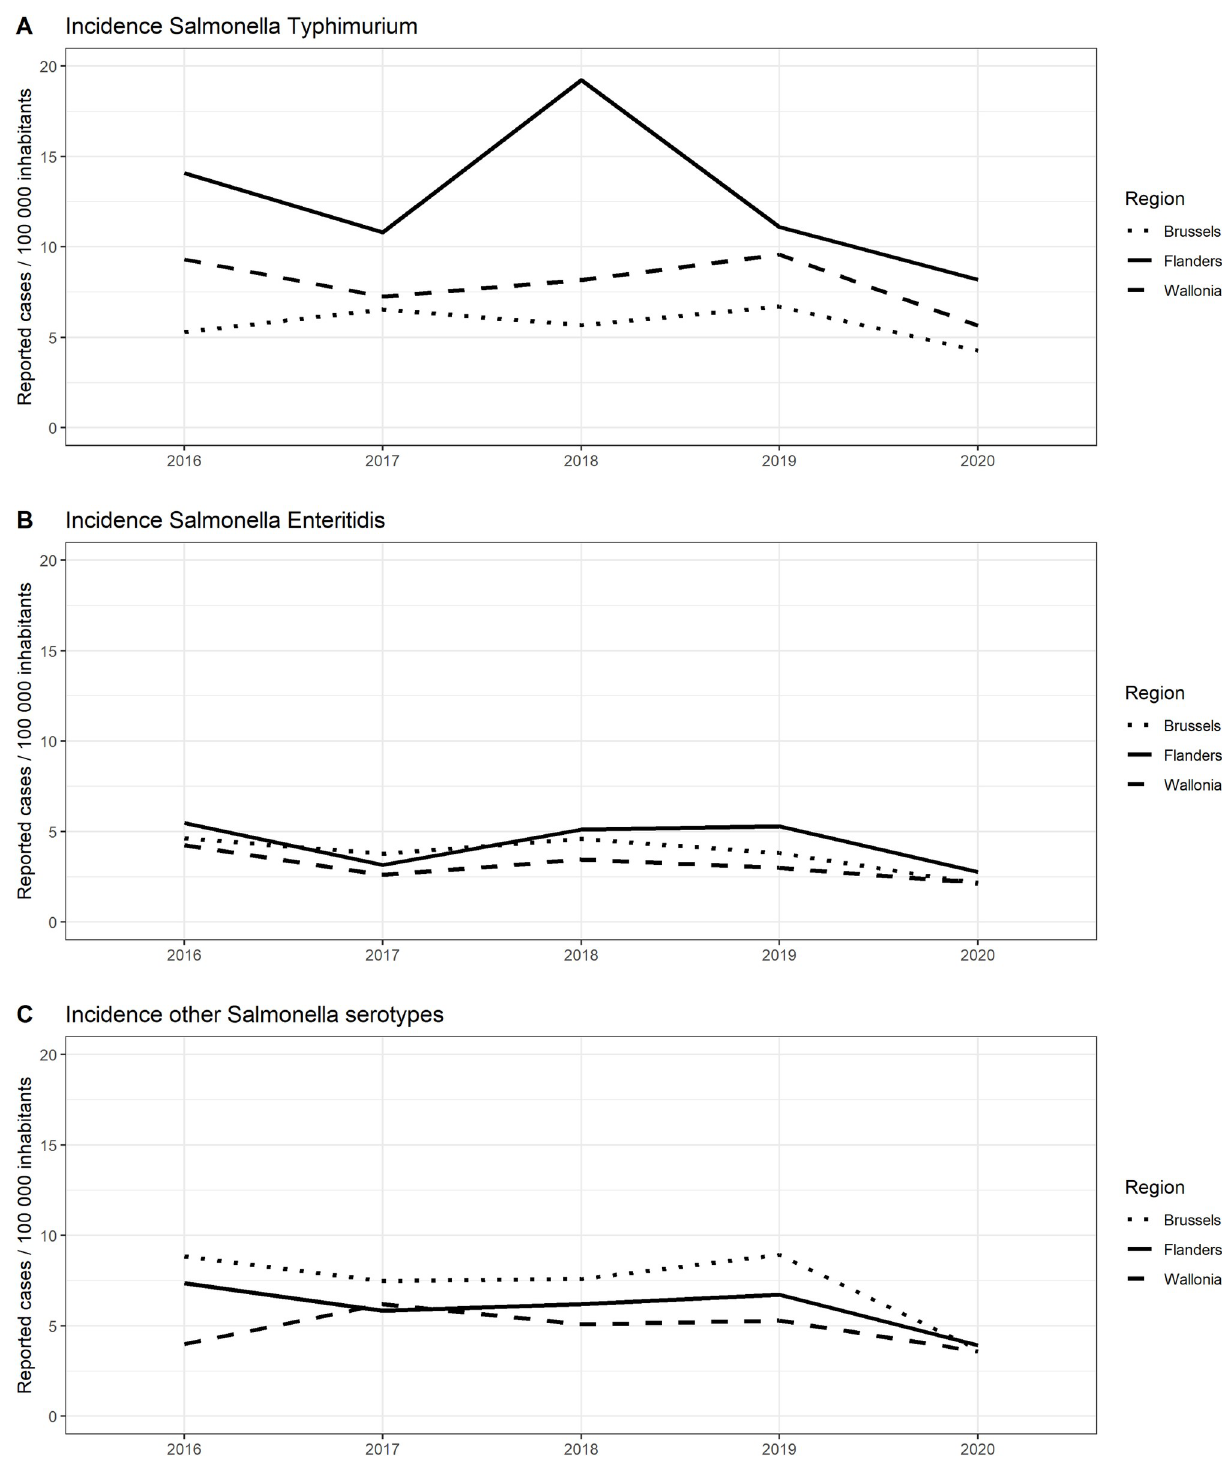
Fig 1. Number of Salmonella cases per 100 000 inhabitants reported by the National Reference Center (NRC) per region, Belgium, 2016–2020. Panel A: Salmonella ser. Typhimurium; Panel B: Salmonella ser. Enteritidis; Panel C: other Salmonella serotypes (panel C).